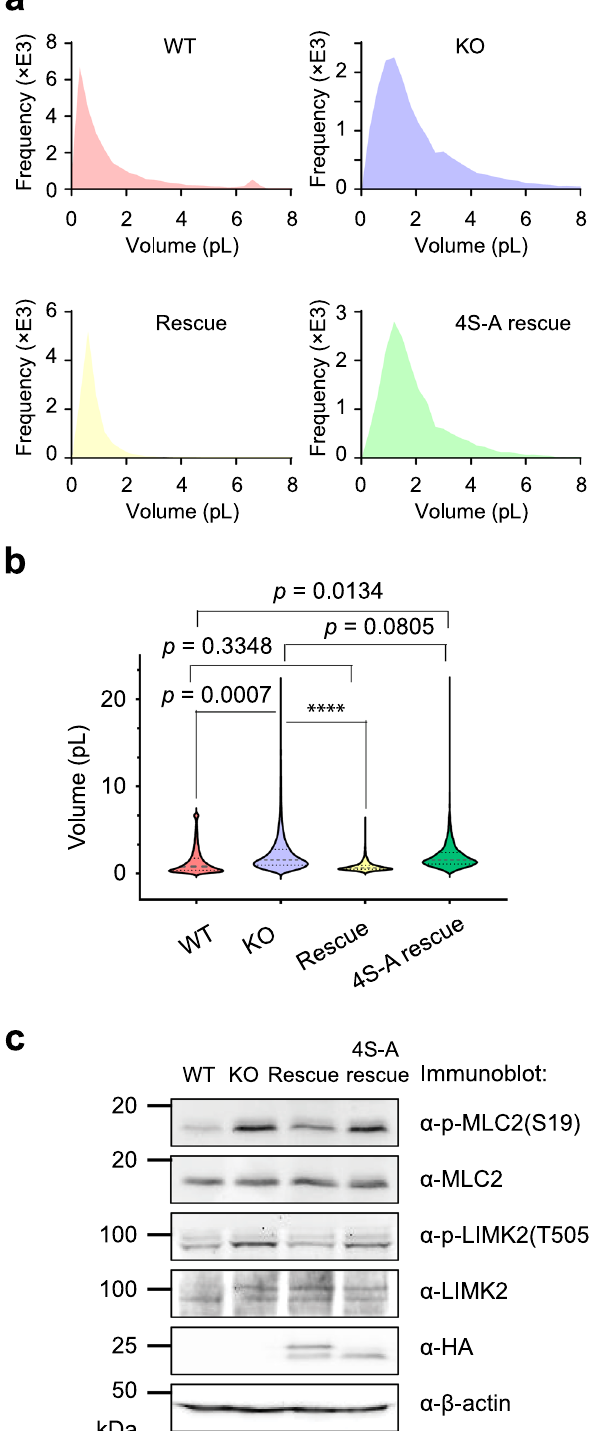
Fig. 6 Alt-RPL36 regulates cell size and morphology. a Cell volume histogram for wild-type (WT), alt-RPL36 knockout (KO), rescue with wild- type alt-RPL36-FLAG-HA (Rescue), or rescue with nonphosphorylatable 4S-A mutant alt-RPL36-FLAG-HA (4S-A rescue) HEK 293T cells. b Violin plot of the cell volume of the four cell lines described above. Signi fi cance was evaluated with non-parametric Mann – Whitney two-tailed test. **** p < 0.0001. Source data are provided as a Source data fi le. c Western blot of the four cell lines indicated at the top with the antibodies indicated to the right. Data are representative of three biological